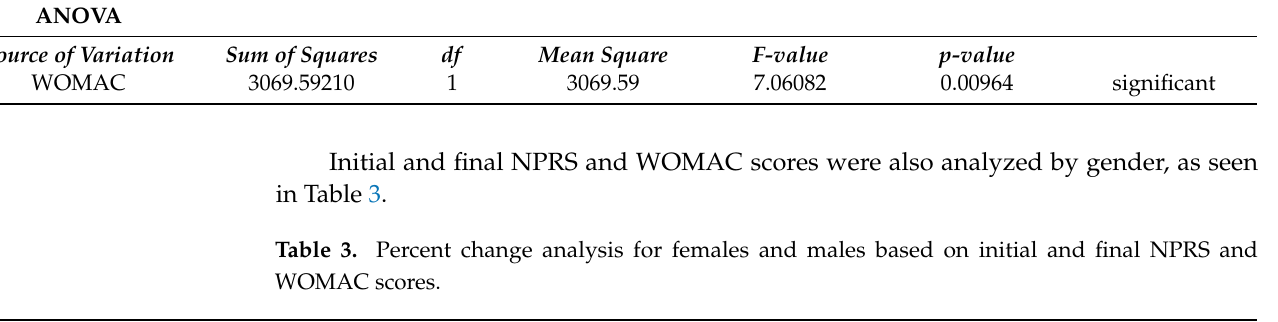
Table 2. Analysis of Variance for WOMAC scores.